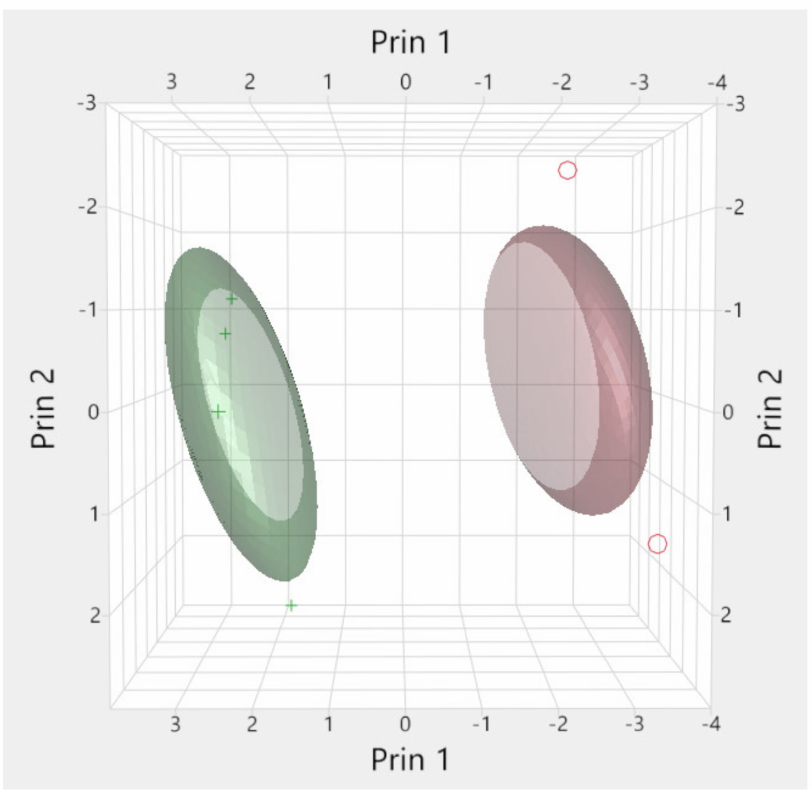
Figure 2. Cluster analysis 3D plot (PC1 and PC2) performed on the selected behavioural activities by horses belonging to HCG (red) and HFG